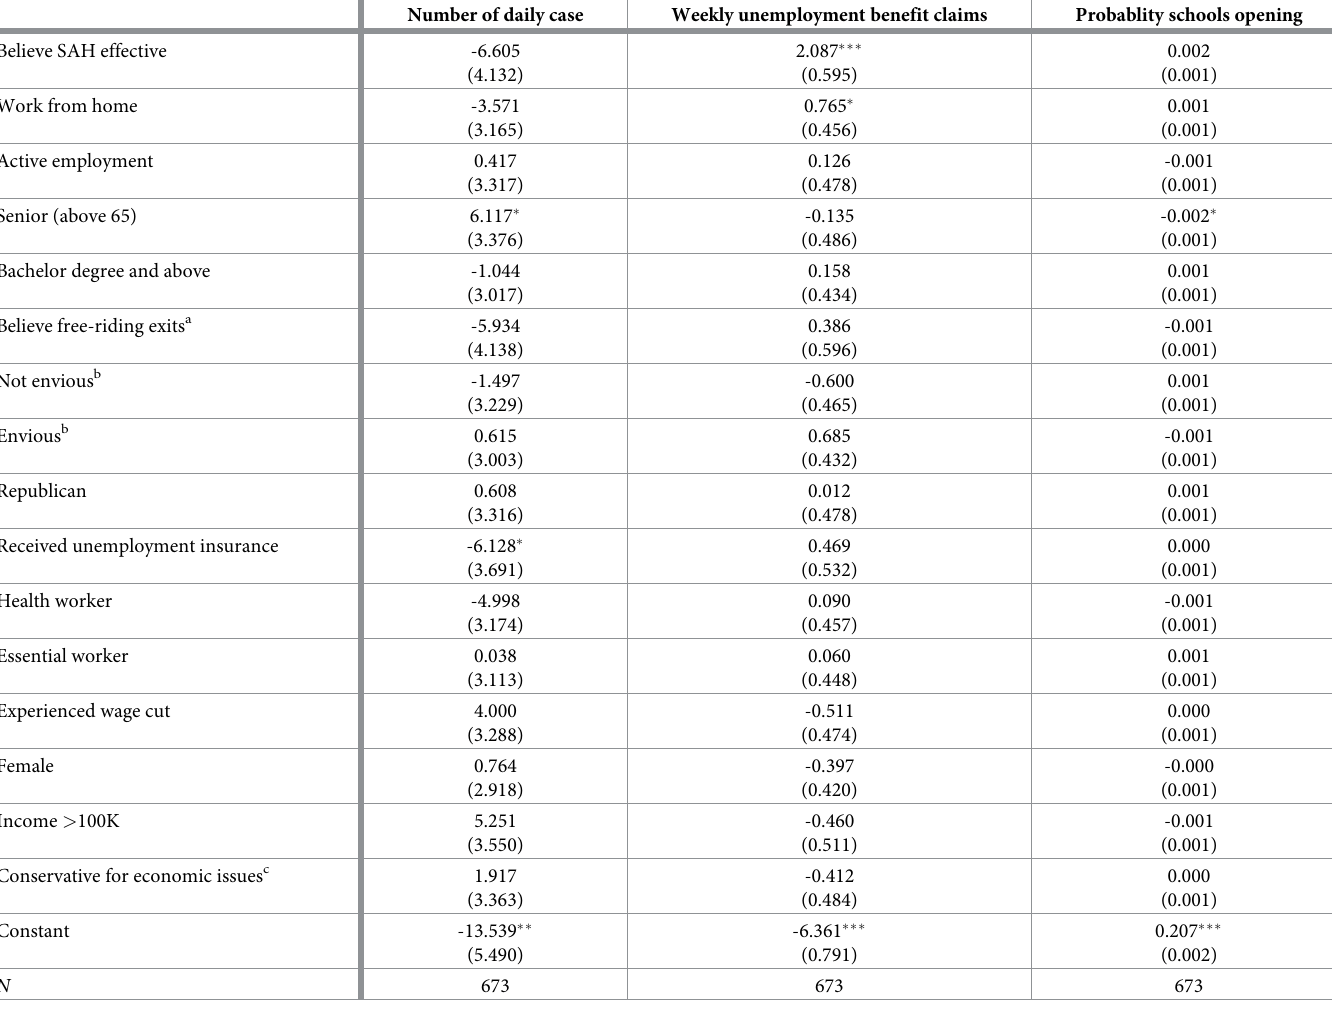
Table 5. Heterogeneity in WTS for different